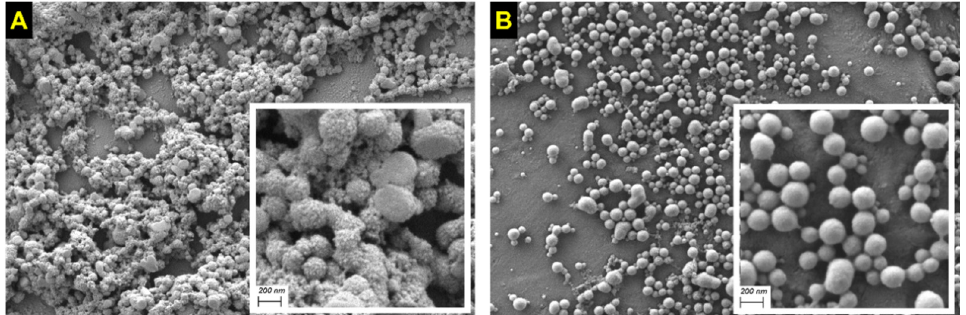
Figure 1. SEM microphotographs of insulin-loaded nanoparticles. ( A ) bare nanoparticles (I-NP); ( B ) PEG-coated nanoparticles (I-NP-PEG). White squares are magnifications of the nanoparticles, in which the scale bar corresponds to 200 nm.